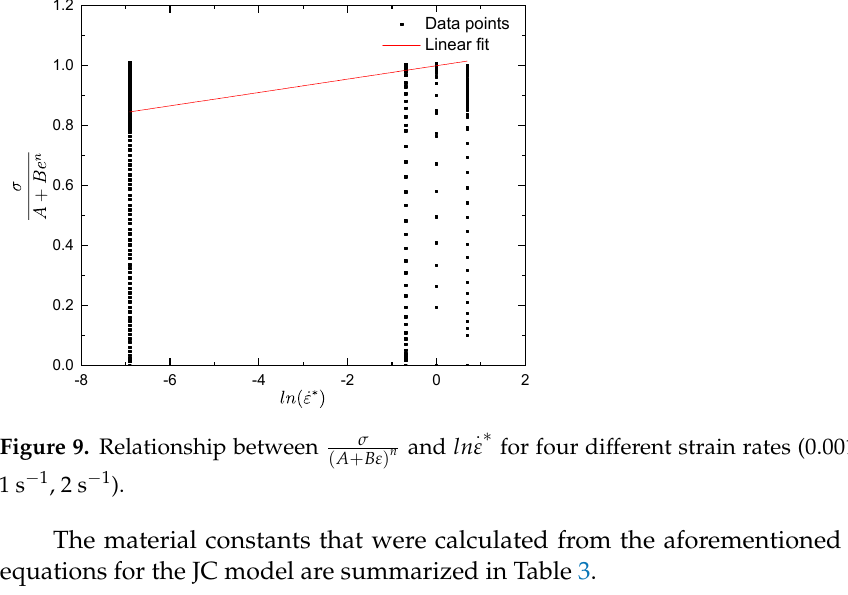
Figure 8. ln( σ − A) and ln ε relationship under reference conditions.